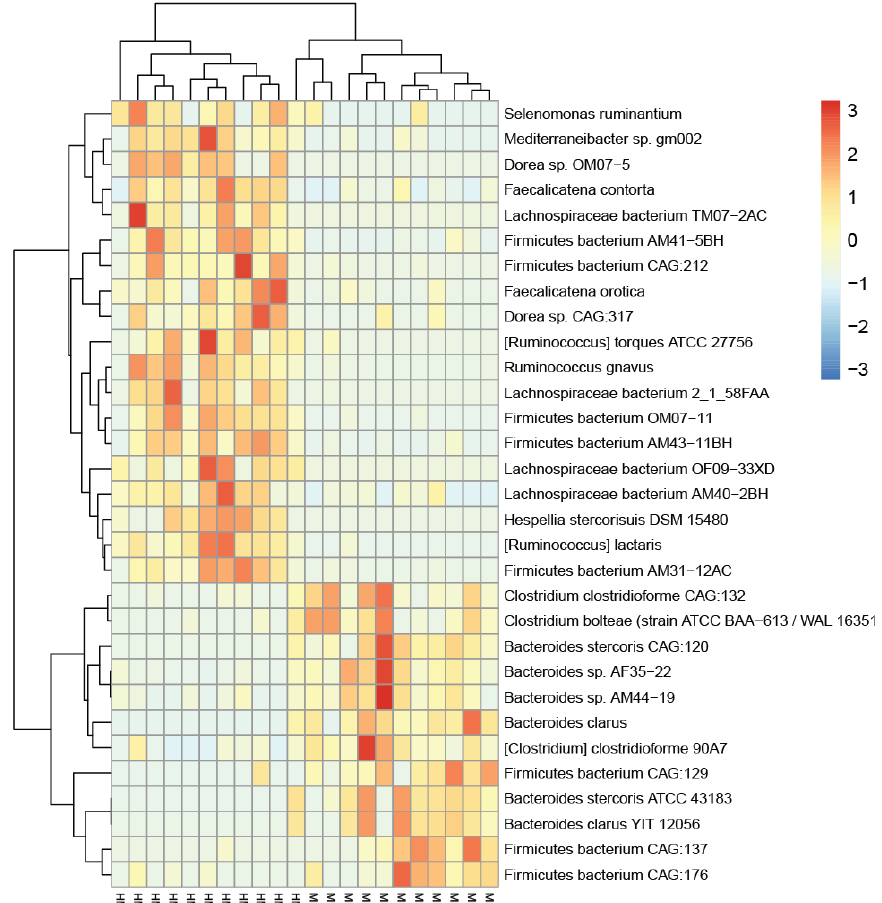
Figure 1. Metaproteomics revealed distinct microbiome profiles in human milk-fed and milk formula-fed neonatal piglets. Heatmap visualization of the top 31 significantly abundant bacteria is shown. The two phenotypes are indicated by the bottom labels: HM and MF ( n = 11/group). Unsupervised clustering of the metaproteomics-derived bacterial abundance resulted in HM and MF piglets being grouped together, except for one outlier from the HM group.